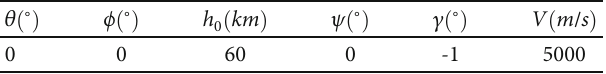
Table 1: Initial states of the entry vehicle.